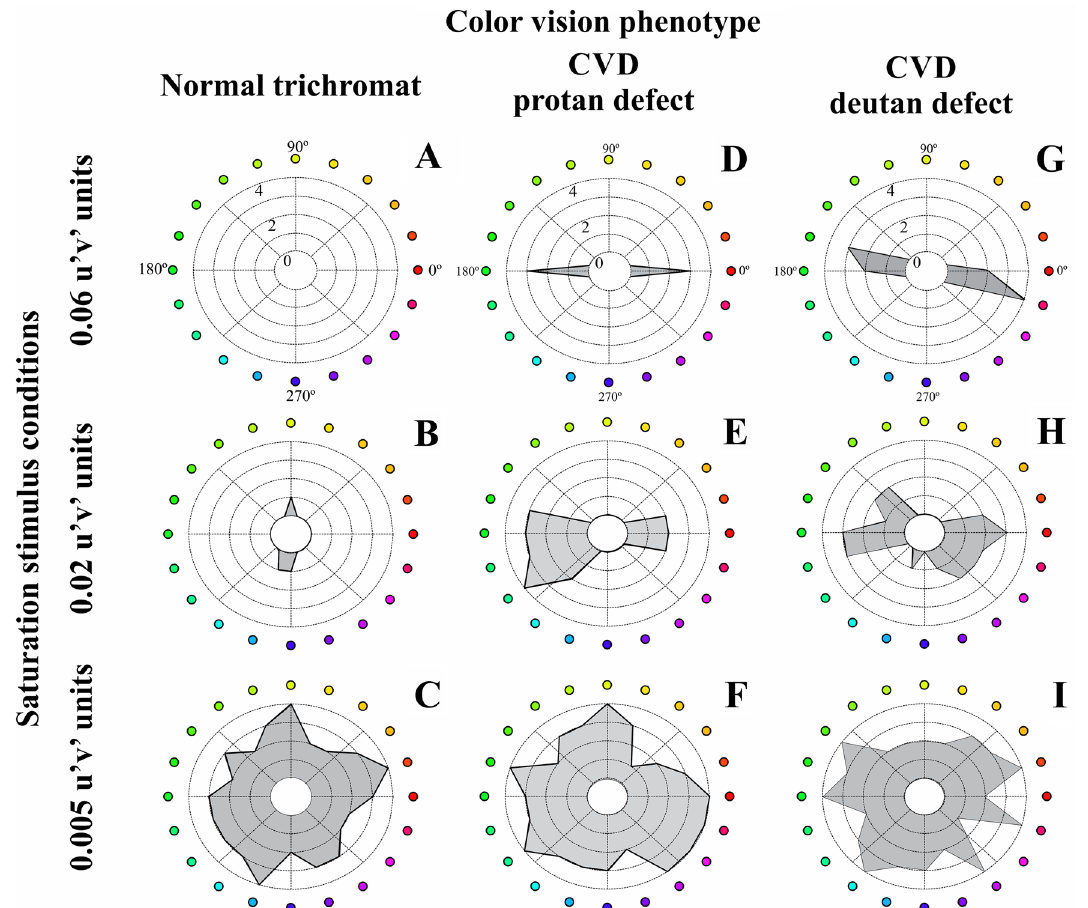
Figure 3. Polar representation of the chromatic discrimination in fixed saturation levels as proposed at the present study for a normal trichromat (A–C) , a participant with CVD and protan defect (D–F) , a participant with CVD and deutan defect (G–I) at three stimulus saturations (0.06, 0.02, 0.005 u’v’ units). In the polar plot, the radius of the circle represents the number of errors (from 0 to 4) during the chromatic discrimination task. The angle represents the chromatic axes. Shaded areas represent the errors in the different chromatic